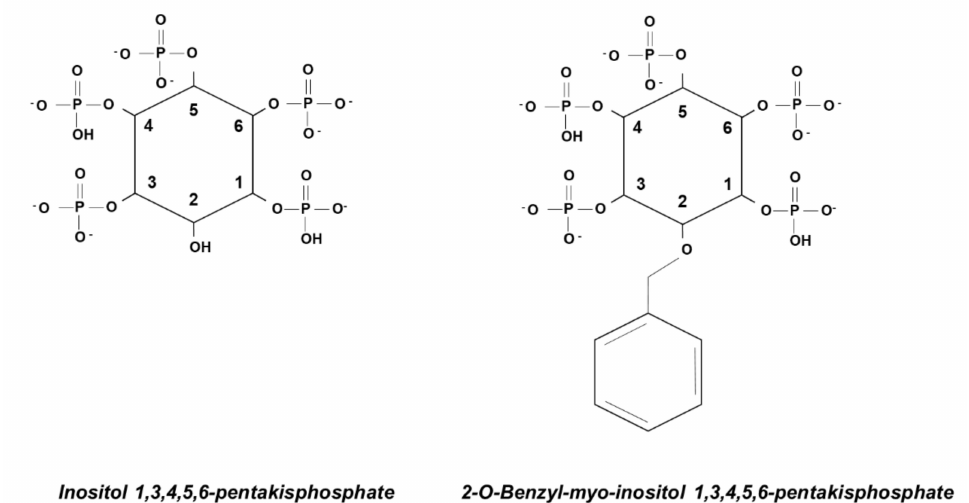
Figure 5. Schematic representation of Ins P 5 and its derivative 2- O -Bn-Ins P 5